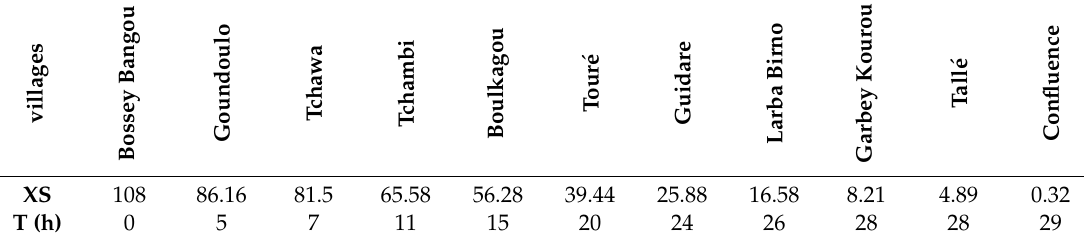
Table 9. Flood propagation time [h] from the Bossey Bangou gauging station: L is the distance from the upstream gauging station and XS is the number of the corresponding